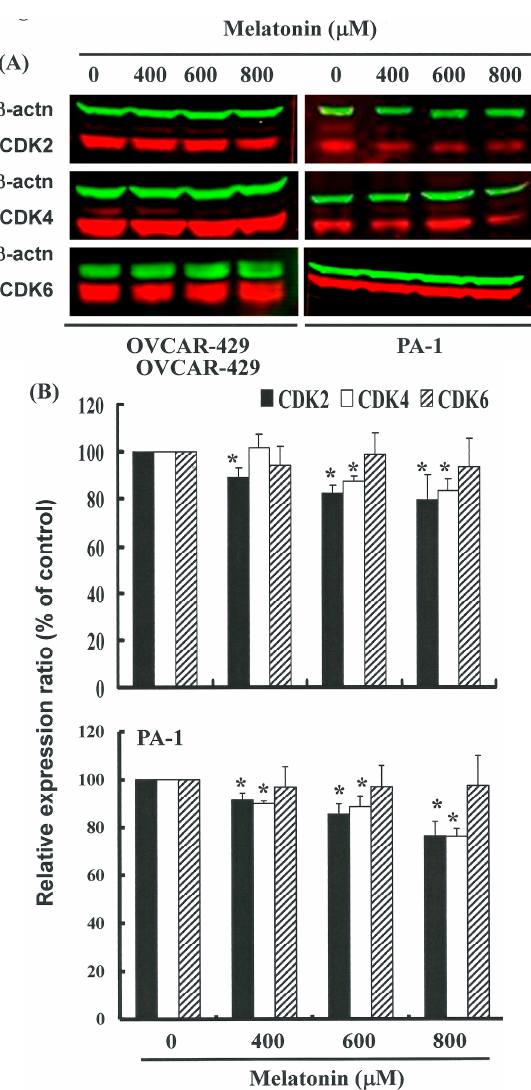
Figure 5. Melatonin represses CDKs gene expression in OVCAR-429 cells. ( A ) The cells were treated with melatonin (0, 400, 600, and 800 µM) for 24 h and gene expression of CDKs was subsequently detected by Western blot analysis; representative blot from three independent experiments; ( B ) Quantification of band intensities. Results are expressed as a percentage of the control sample, which was set at 100%. All data is presented as the mean (±SEM) of no fewer than three experiments. t -tests were used for all statistical analysis with significant differences determined by a p value of * <0.05 versus 0 µM control group.